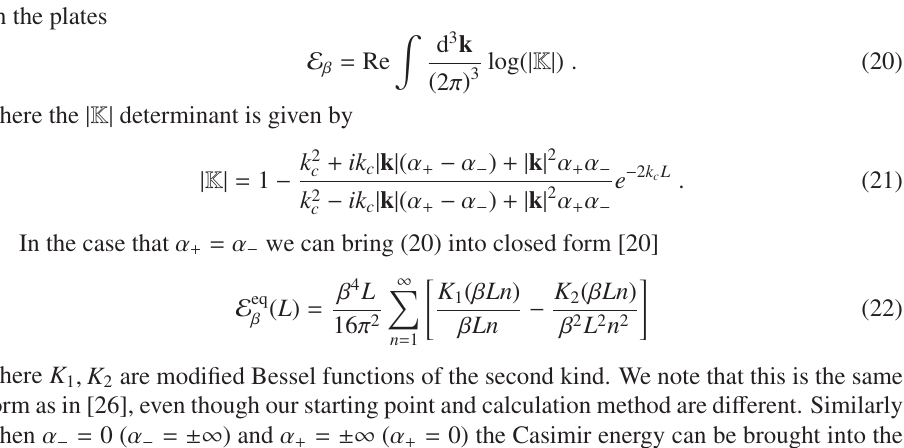
(cid:2) F eq ) and when α − = 0 ( α − = ±∞ ) and α + = ±∞ ( α + = 0) ( 8